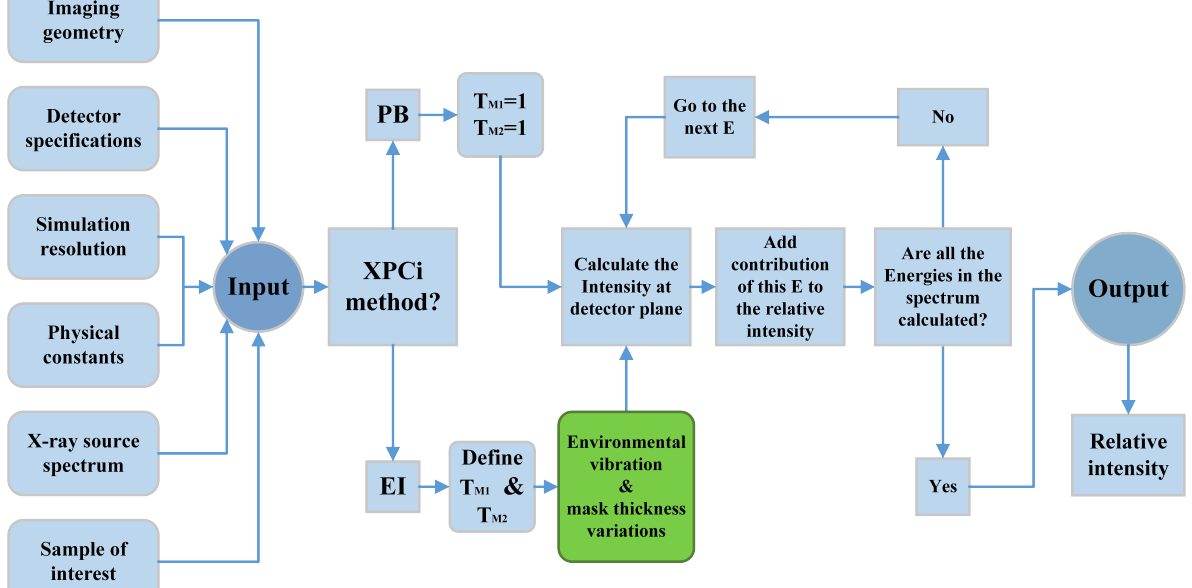
Figure 3. Algorithm used to simulate the model for both PB-XPCi and EI-XPCi configurations in MATLAB ® . The green block represents where absorption mask thickness variation and mechanical vibration are defined in the